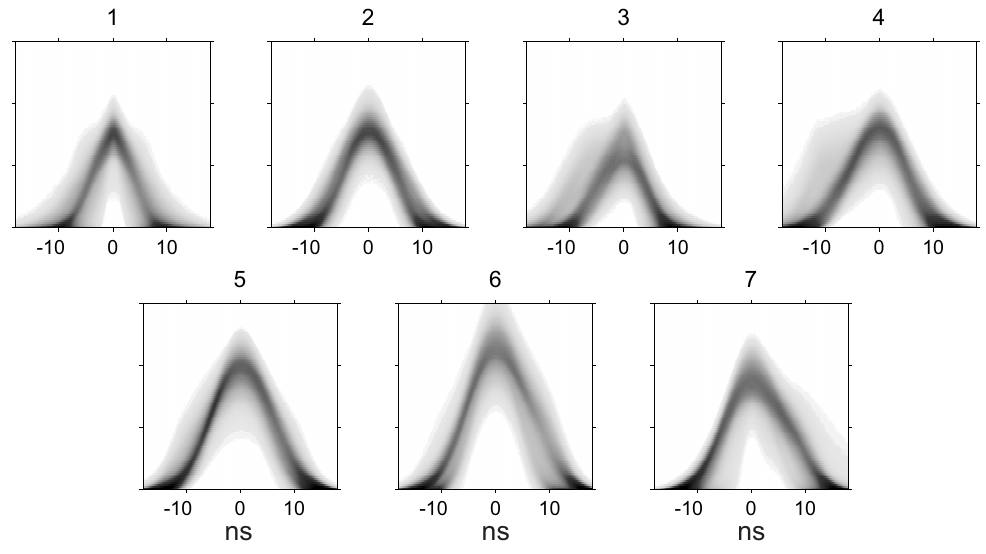
Figure 7. Bottom return pulse shapes and their distributions for the seven clusters.